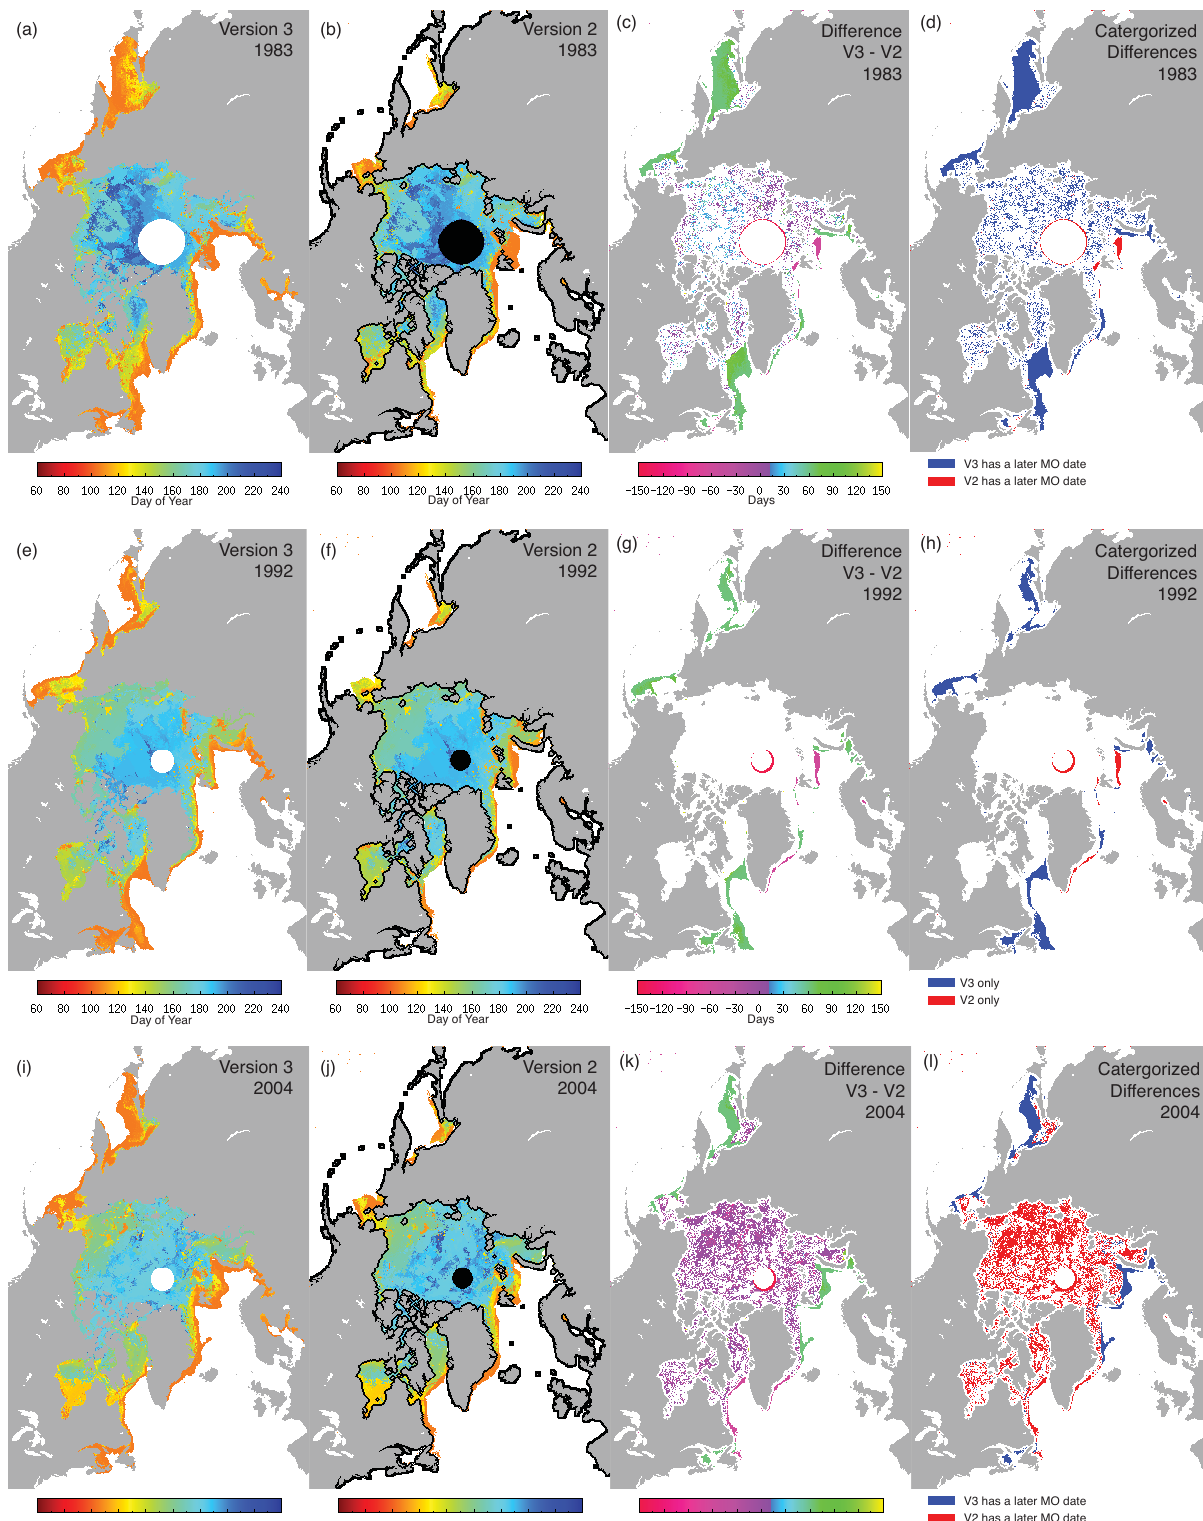
Figure 3. Comparison of V2 and V3 MO dates for 1983, 1992, and 2004. Difference maps show V2 MO dates subtracted from V3 MO dates. Categorized difference maps classify the differences between V2 and V3 MO dates by the type or cause of the differences between versions.